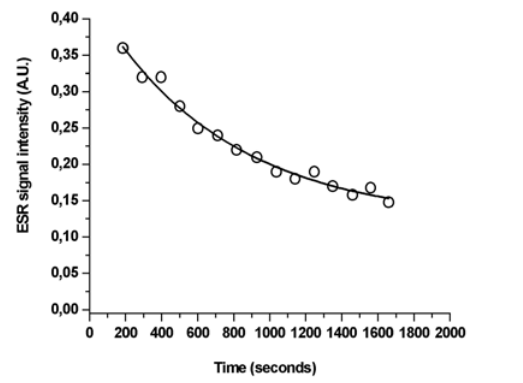
FIGURE 2. The time course of the ESR signal intensity in model Fenton reaction. The model Fenton reaction